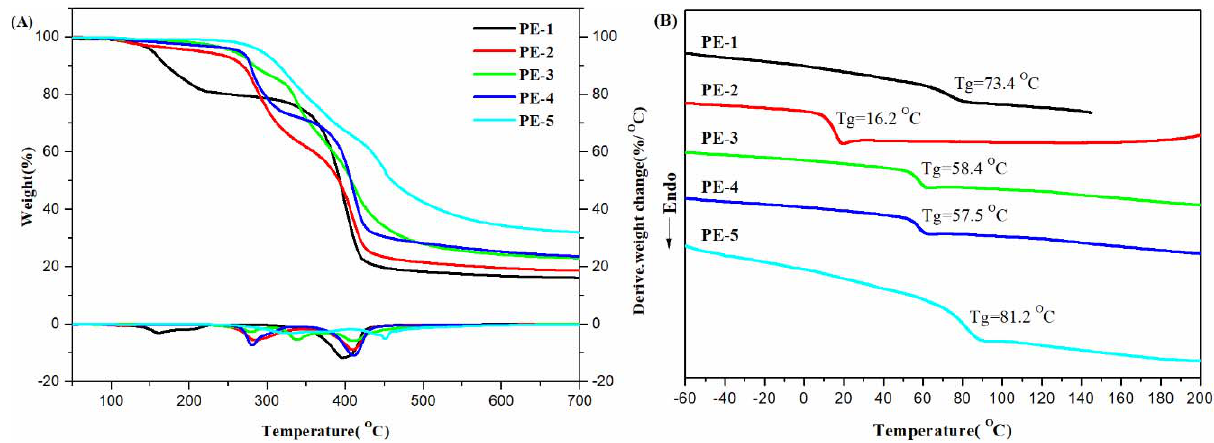
Figure 4. TGA curves ( A ) and differential scanning calorimetry (DSC) traces ( B ) of PEs. Reprinted from [19] with permission of MDPI.